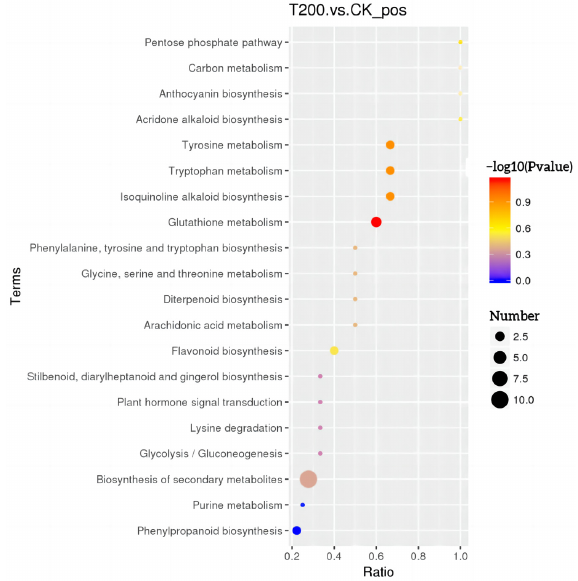
Figure 4. Map representing the KEGG pathway enrichment of non-targeted metabolites in roots. The horizontal axis represents the metabolic pathway ratio of T200 and CK groups, and the vertical axis represents KEGG terms. Different colors represent different p -values, ranging from blue at the lowest end of the spectrum (denoting a small p -value) to red at the highest end (denoting a large p -value). The size of the spot represents the number of microorganisms enriched in a given pathway. Correlations between the bacterial genera colonized in the rhizosphere soil and root metabolites in the T200 and CK groups were analyzed in the current study, and the Figure